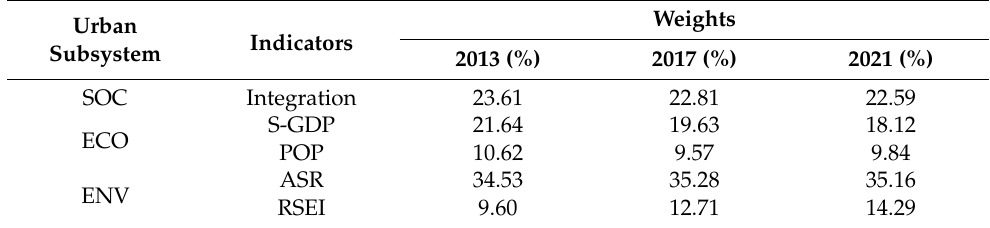
Table 4. The weights in